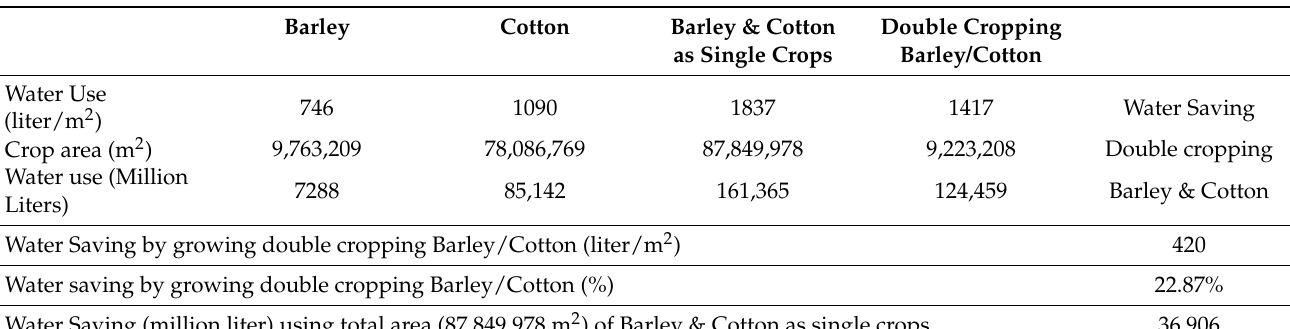
Table 5. Difference in water consumption between barley/cotton double-cropping and barley and cotton as single crops (2002